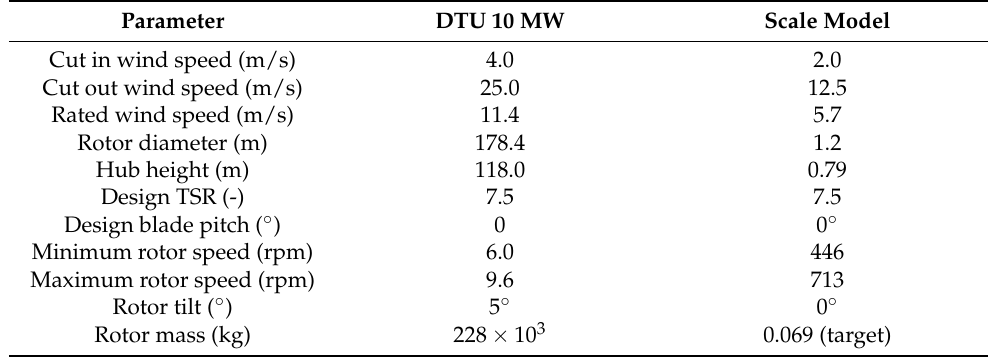
Figure 1. Dimensions of the wind turbine scale model are compared to typical wind profiles of the POLIMI wind tunnel and to the main dimension of the wind tunnel test section. ( a , b ) Vertical profile of average wind speed and turbulence intensity (TI) at the test section inlet for three terrain conditions (error bars are the min/max across the test section, “Target” is the typical logarithmic profile for the site, and the grey area corresponds to the rotor dimensions). ( c ) Main dimensions of the wind tunnel, the dashed area is occupied by roughness elements and is used to generate wind with controlled characteristics. Table 1. Properties of the DTU 10 MW rotor and scaled values for the wind turbine